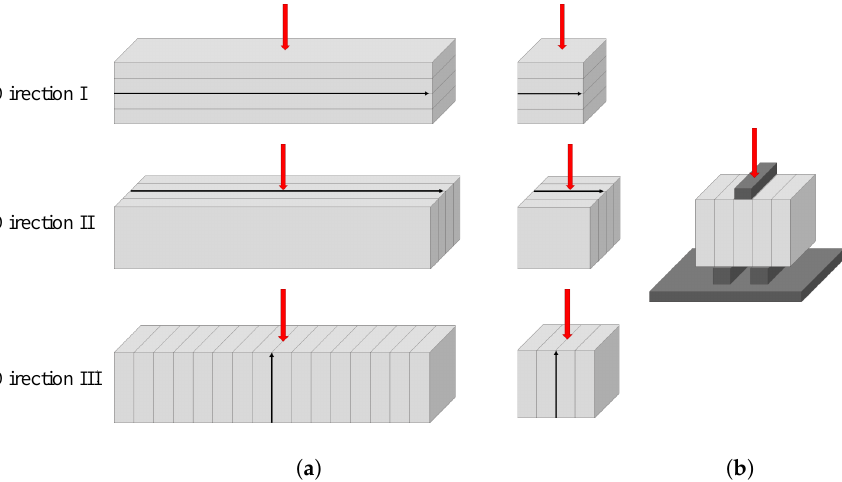
Figure 5. ( a ) Schematic drawing of the three loading directions for compression and flexural specimens, and ( b ) schematic drawing of the custom-made apparatus used to the interlayer shear strength test.